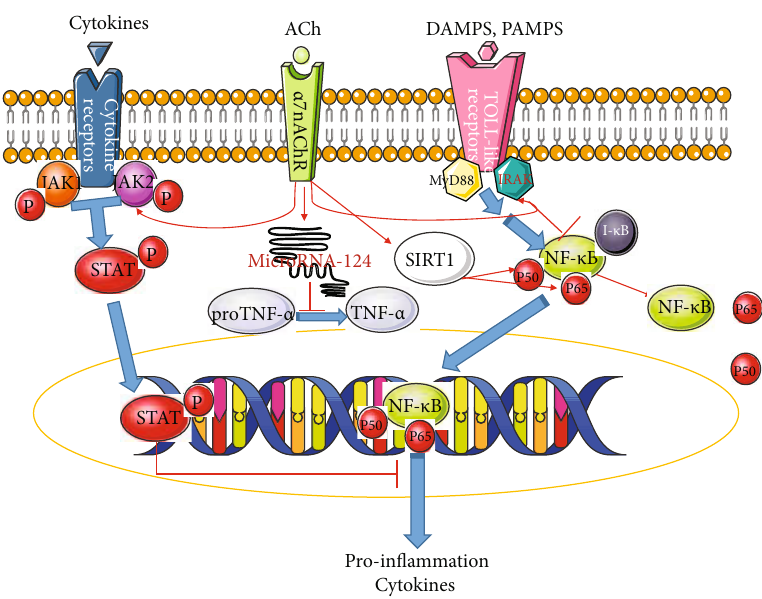
Figure 2: Some known paths of activated α 7nAChRs to suppress in fl ammation. Activated α 7nAChRs inhibit the generation of proin fl ammatory cytokines through several intracellular paths. These mechanisms involve negatively regulating the NF- κ B path and facilitating the synthesis of P-STAT, SIRT1, and microRNA-124. DAMPs: damage-associated molecular patterns; PAMPs: pathogen- associated molecular patterns; JAK2: tyrosine kinase 2; STAT: signal transducer and activator of transcription; IRAK: interleukin-1 receptor-associated kinase. Blue arrow, the normal signal path; red arrow, promoting; red line,